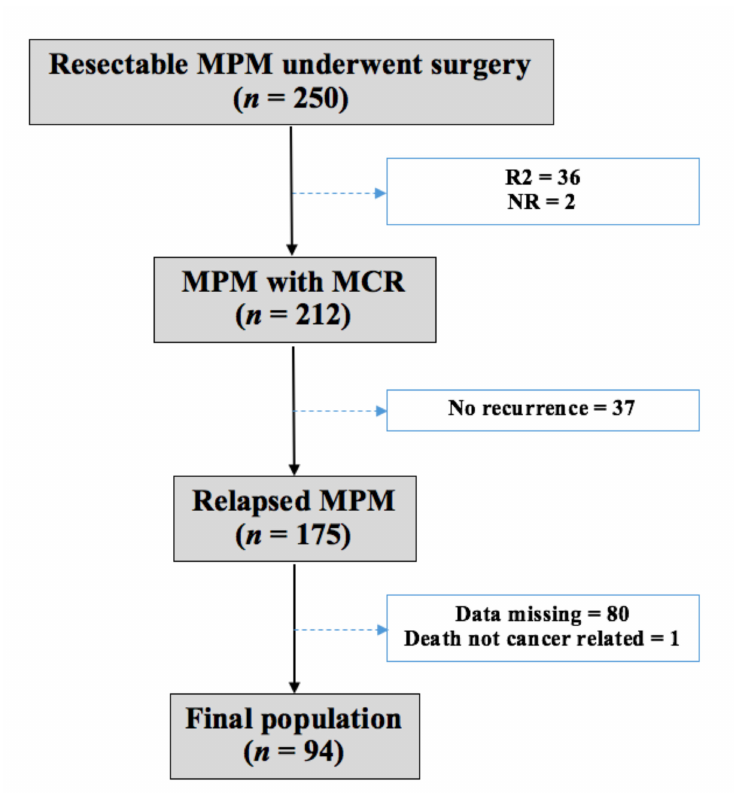
Figure 1. Population. MPM—malignant pleural mesothelioma; R2—incomplete macroscopic resec- tion; MCR—macroscopic complete